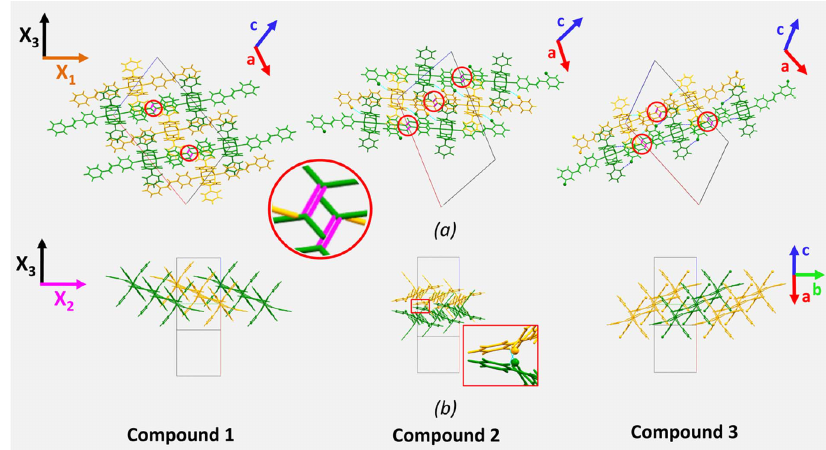
Figure 5 Representation of the crystal structures of compounds 1 – 3 , ( a ) along the crystallographic b axis and ( b ) in the [101] direction. The principal axes ( X 1 , X 2 and X 3 ) for the thermal expansion are also shown. Chain-like one-dimensional structural motifs formed by (cid:2) – (cid:2) interactions (indicated by red circles) of the C C double bonds of the styrylpyridine ligands are represented in green and yellow. The inset in ( b ) highlights the interchain interactions in compound 2